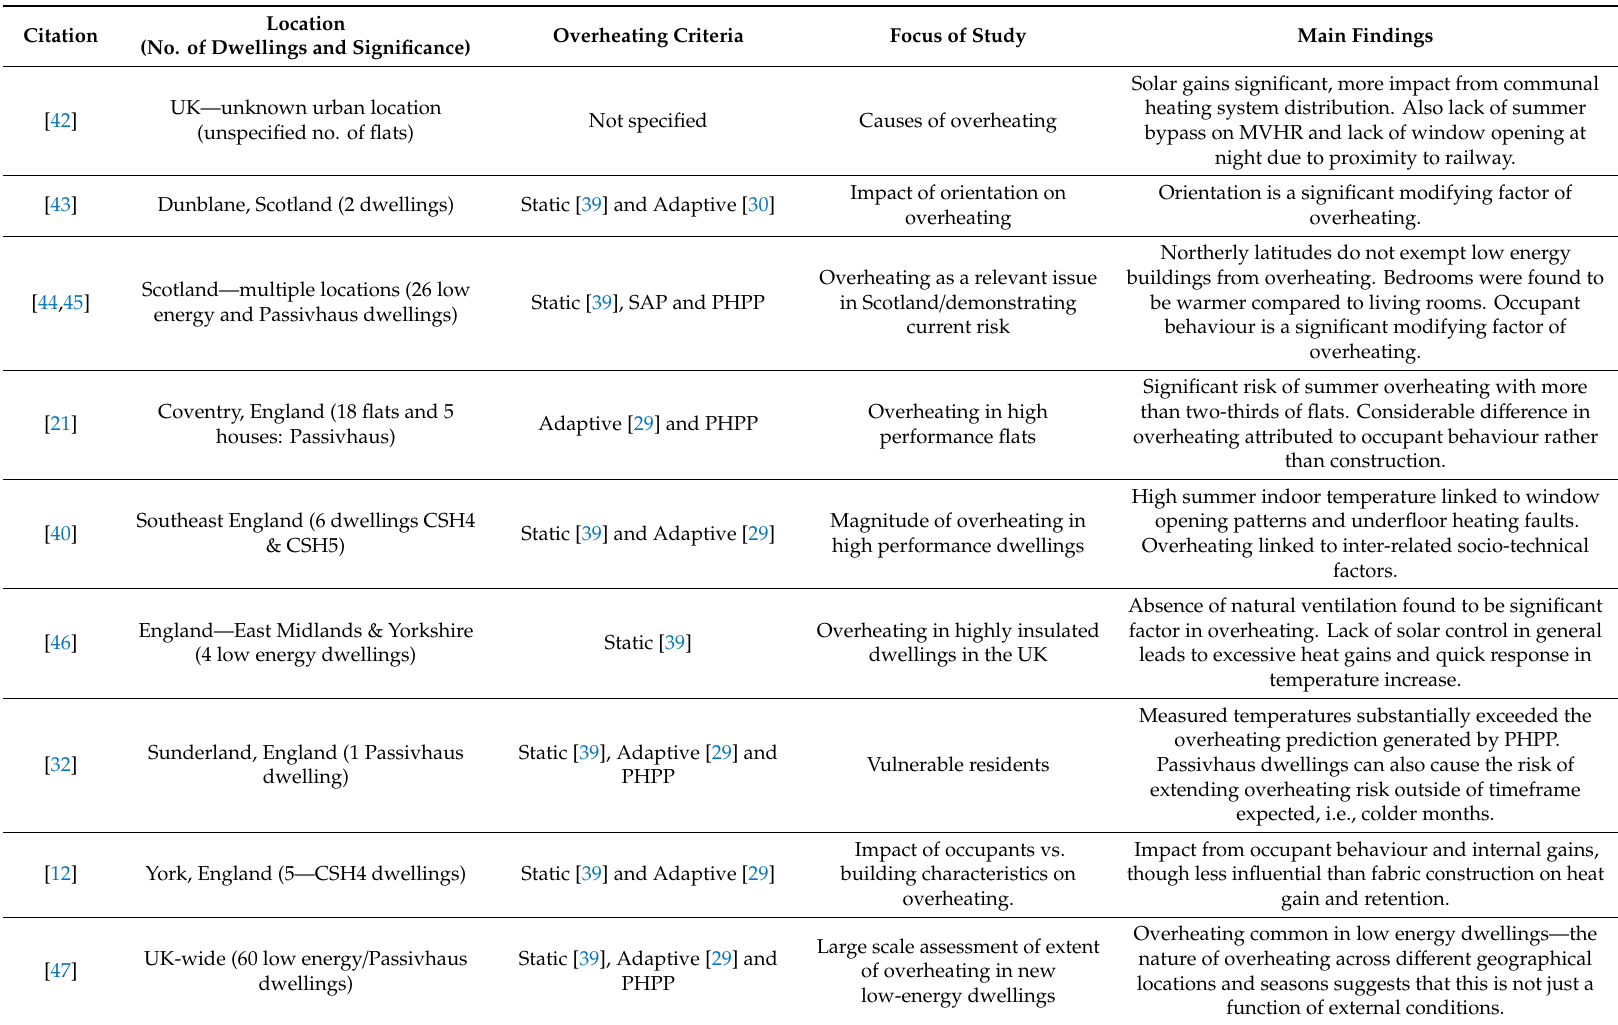
Table 1. Review of literature on overheating in new low energy